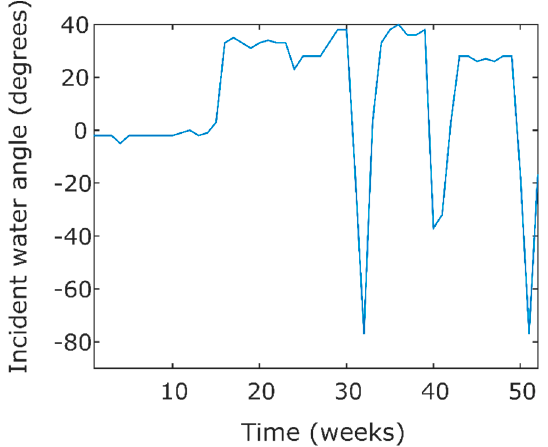
Figure 4. Incident angles of the streaming water over the measured weeks, at north East London, South Africa, presented in [34].